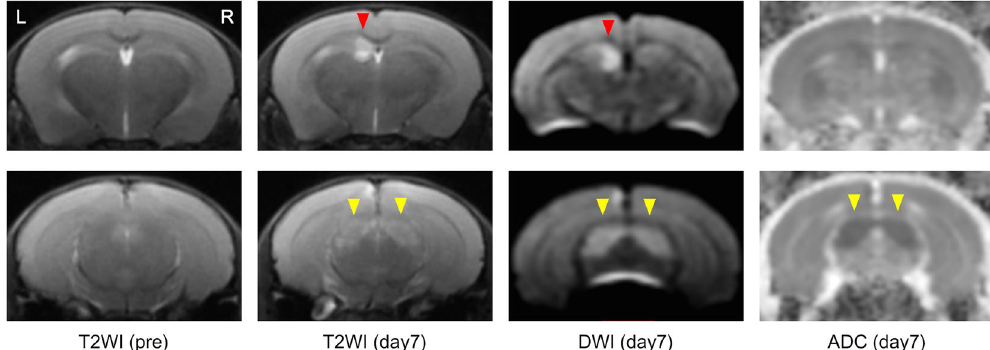
Figure 1. Brain magnetic resonance (MR) imaging. MR images on day 7 of the KO mouse (Animal Code: KO-5 in Supplementary Table 1) that died on day 11 after surgery are shown. Cerebral infarction is seen in the caudate nucleus (red arrowheads), and pre-Wallerian degeneration is seen in the cerebral peduncle (yellow arrowheads). T2WI, T2 weighted image; DWI, diffusion weighted image; ADC, apparent diffusion